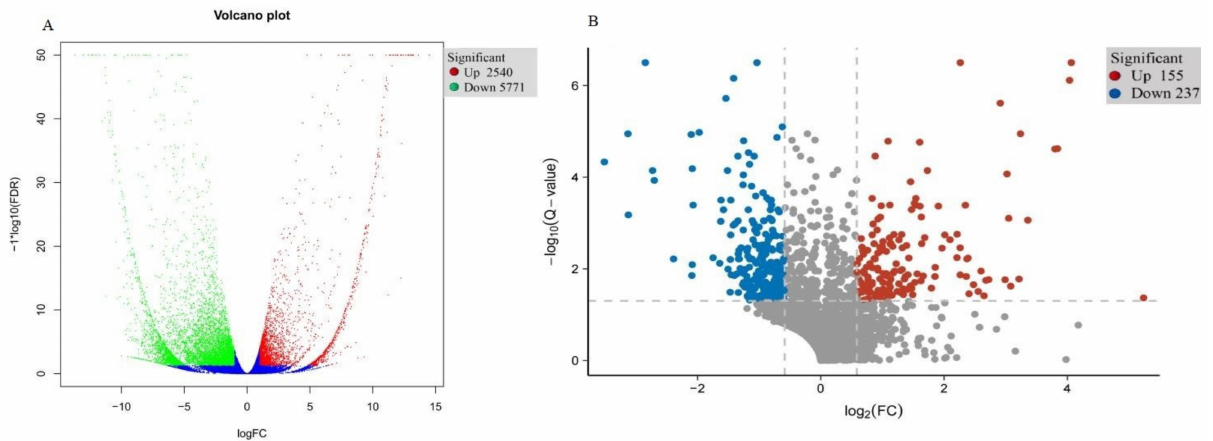
Figure 2. ( A ) Expression pattern of differentially expressed genes in T51 and WT. ( B ) Expression pattern of differentially expressed proteins in T51 and WT.